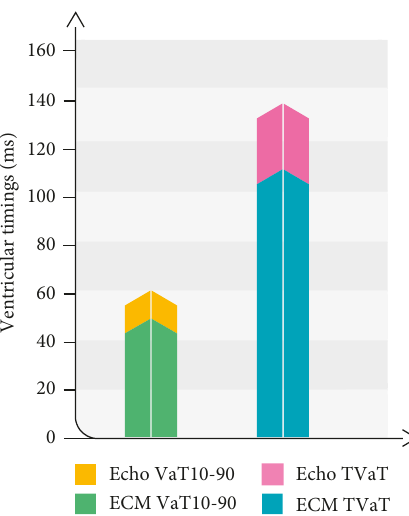
Figure 2: Differences in ventricular activation timings in AVD optimisation by echocardiographic methods and ECM. AVD, atrioventricular delay; echo, echocardiographic mapping; echo TVaT, mean of the TVaT obtained based on the optimal AVD obtained through echocardiographic methods; Echo VaT10-90, mean of the VaT 10-90 index obtained based on the optimal AVD obtained through echocardiographic methods; ECM, electrocar- diographic mapping; ECM VaT10-90, mean of the shortest VaT 10-90 index obtained for the AVD tested; ECM TVaT, mean of the shortest TVaT obtained for the AVD tested.